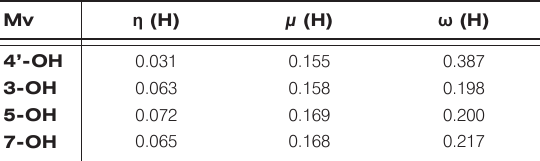
Table 11. Frontier charge density for HOMO of cyanidin, delphinidin and malvidin, respectively (HF/6-31+G(2d,p)). O-atom Q